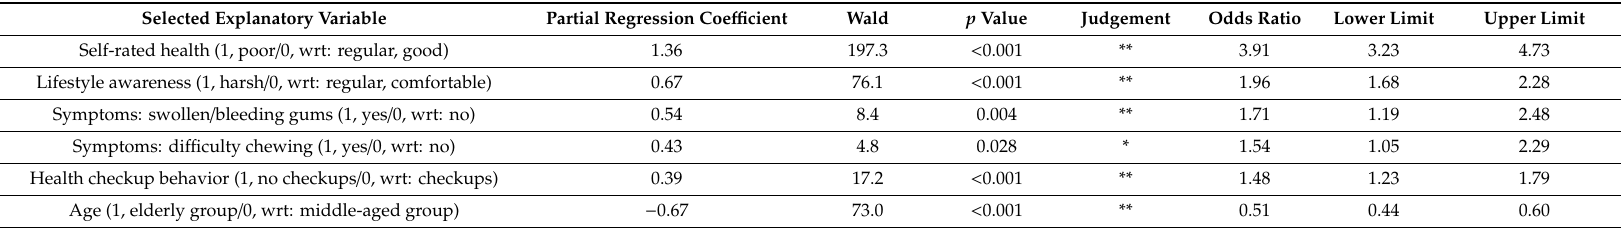
Table 6. Results of logistic regression analysis with presence of worries / stress as the objective